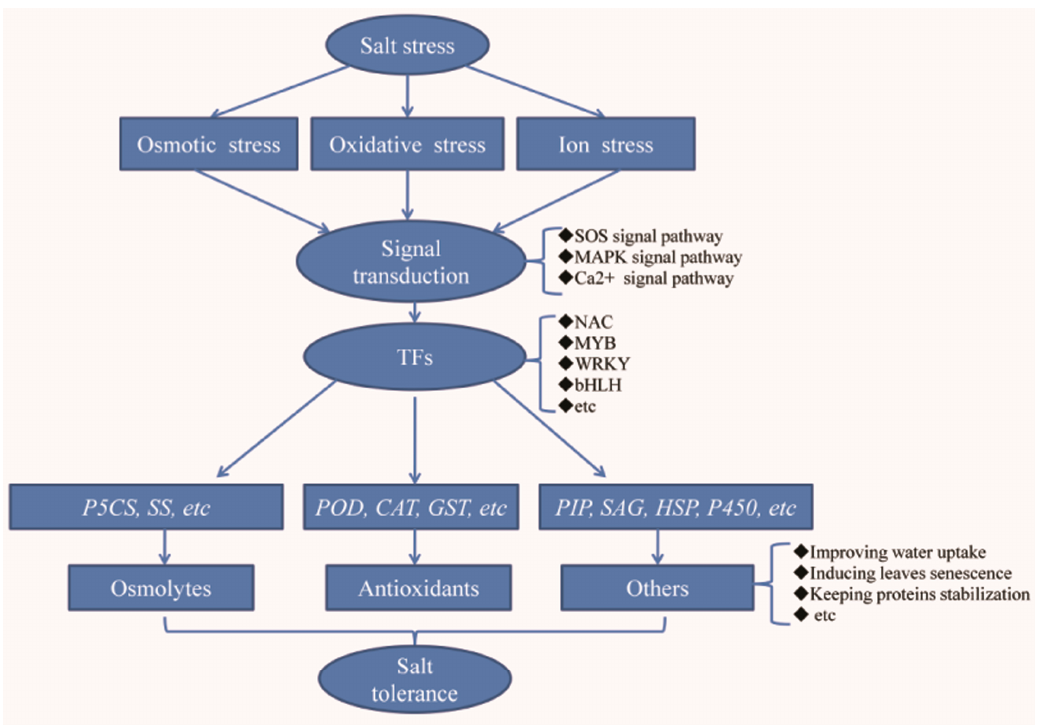
Figure 7. A proposed model of the salt-stress response in Chinese cabbage.